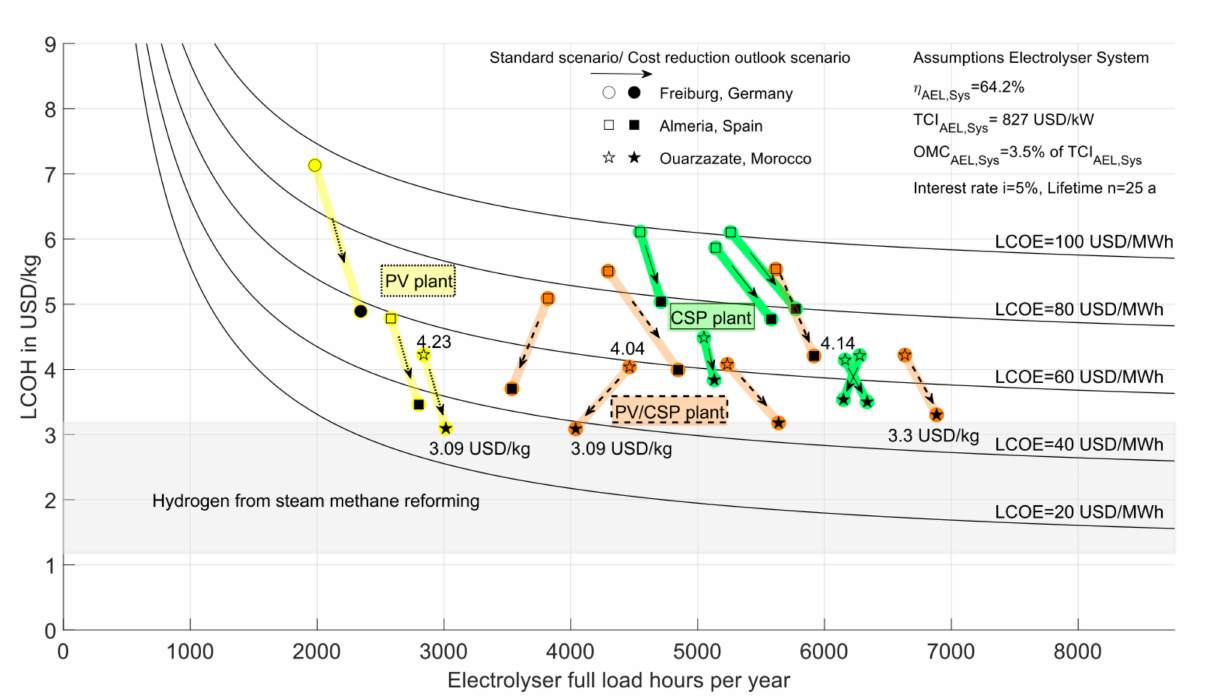
Figure 8. Levelized cost of hydrogen (LCOH) depending on electrolyser full load hours and levelized costs of electricity provided to the electrolyser (LCOE). Each simulation value for three locations and two costs scenarios was obtained by cost minimization for different stand-alone hydrogen production